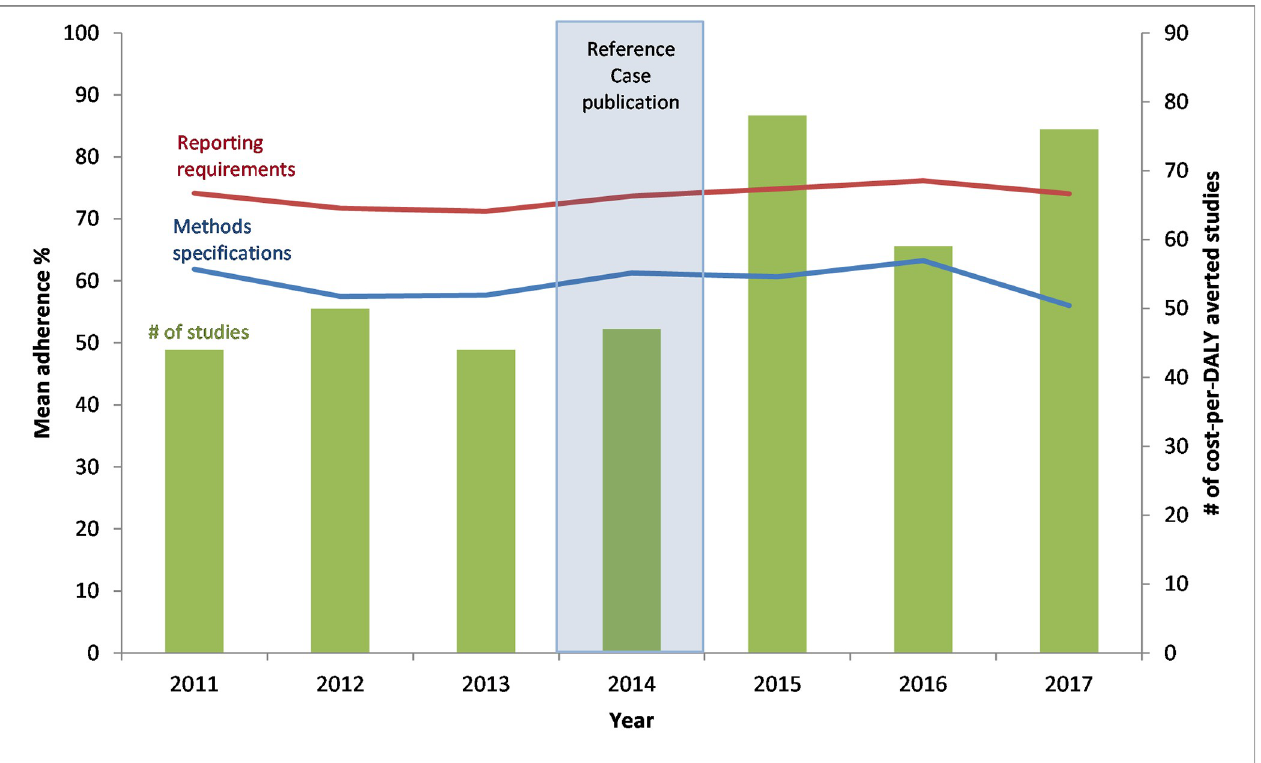
Fig 1. iDSI reference case adherence scores and number of cost-per-DALY averted studies over time.